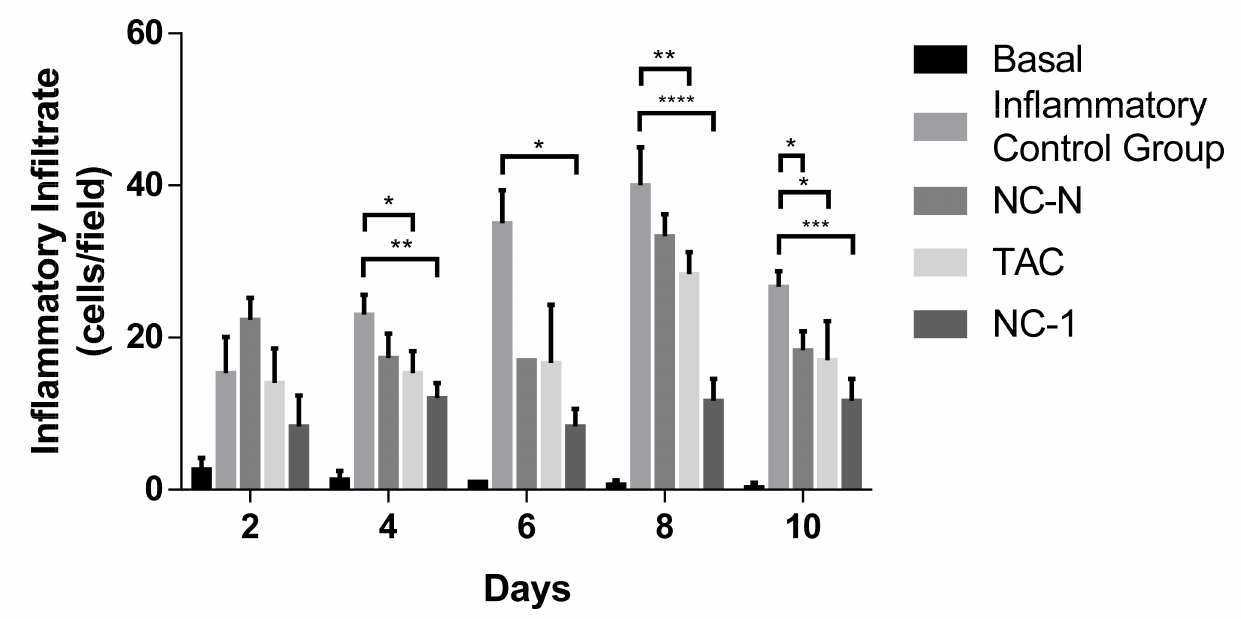
Figure 9. Effect of TAC, non-loaded, and TAC-loaded nanocapsules (NC-N and NC-1) on TPA-induced ear cell infiltration of male Balb/c mice. Statistical analysis performed on each group on days 2, 4, 6, 8, and 10 of treatment. ANOVA statistical test with Tukey post-test, with significance of * p < 0.05; ** p < 0.01; *** p < 0.001, and **** p < 0.0001, when compared to the inflammatory control group (ICG).